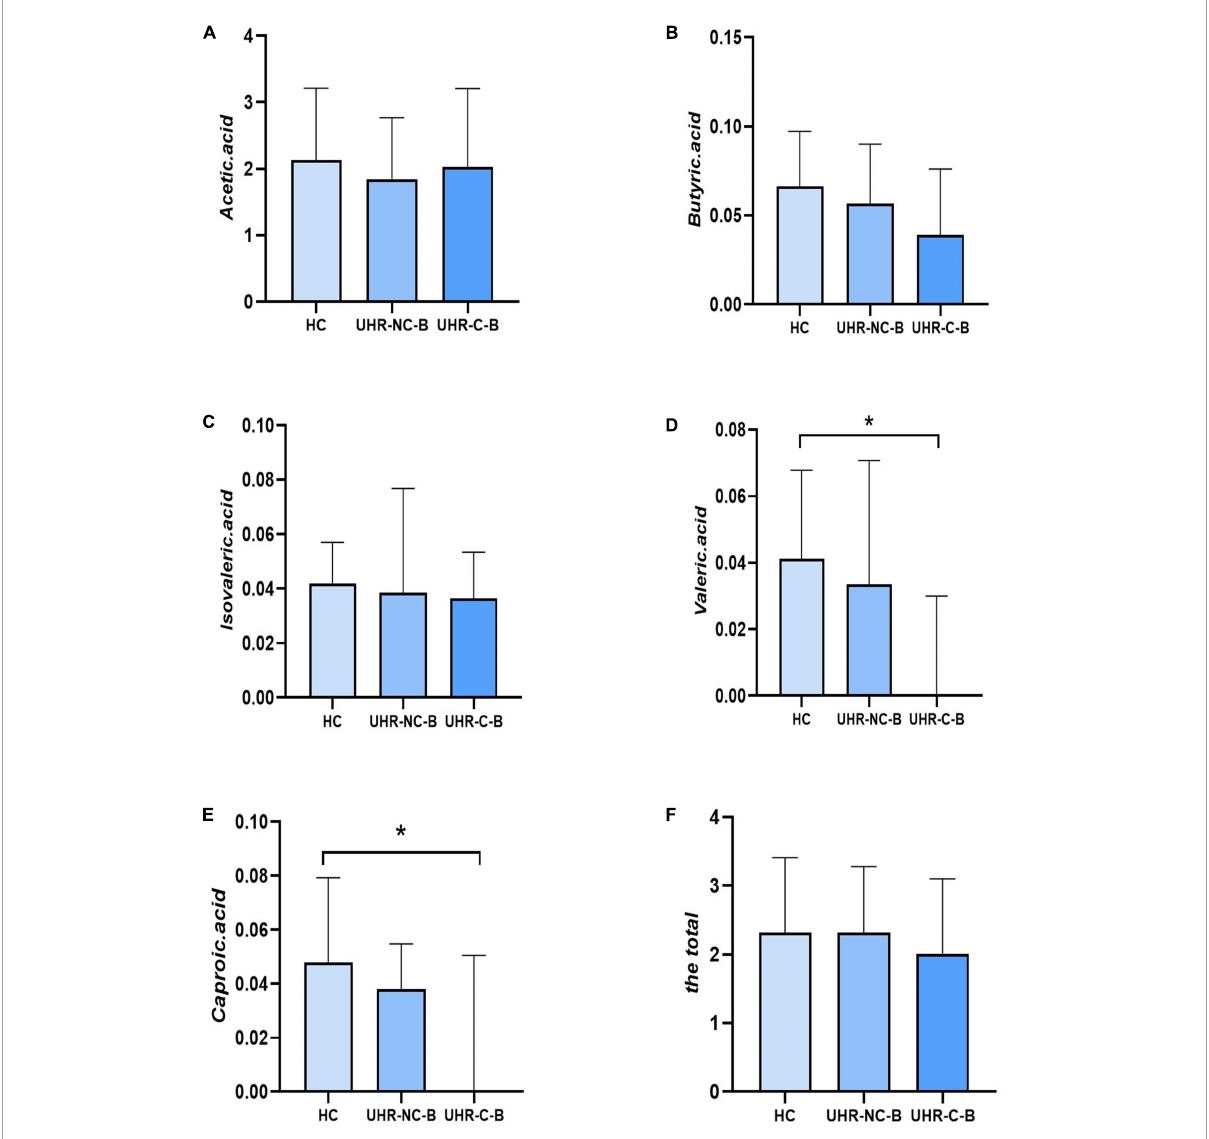
FIGURE2 The comparison of short-chain fatty acids (SCFAs) content among the baseline of converted ultra-high risk participants (UHR-C-B), the baseline of non-conversed ultra-high risk participants (UHR-NC-B), and the healthy controls (HC) group. (A–F) Showed the comparison of acetic acid, butyric acid, isovaleric acid, valeric acid, caproic acid and the total SCFAs levels, respectively among Group HC, Group UHR-NC-B and Group UHR-C-B. * p <